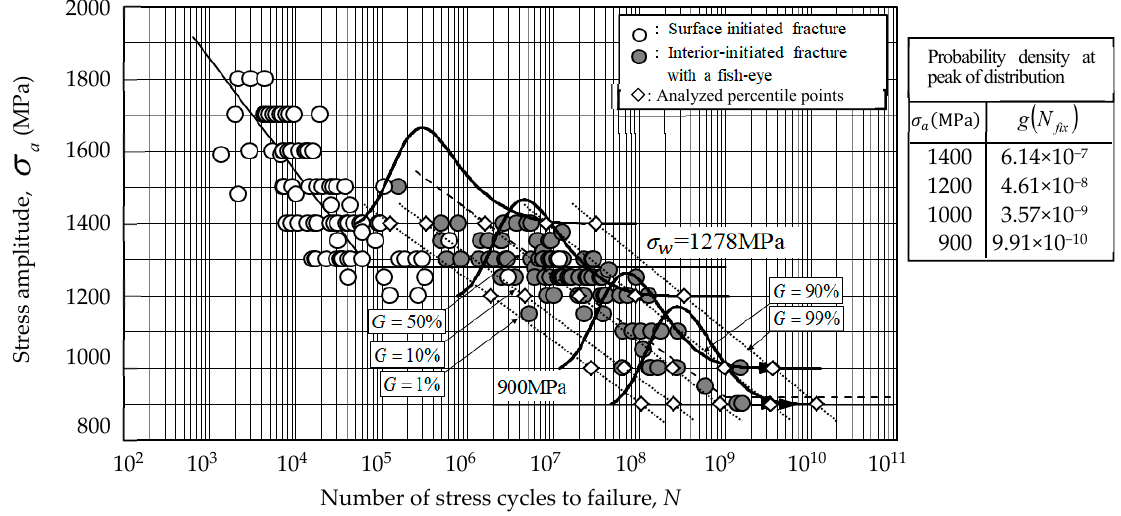
Figure 12. Fatigue life distributions and P-S-N curves in a very high cycle regime.